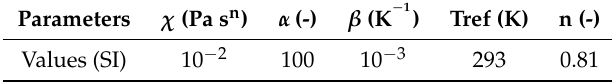
Table 1. Typical values of the viscosity model parameters.